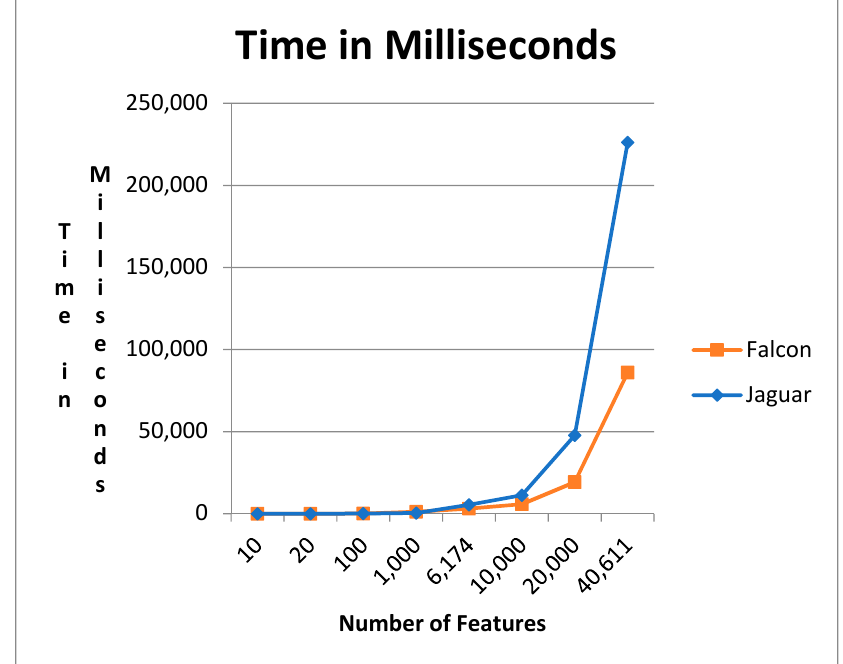
Figure 7. Average time in milliseconds.